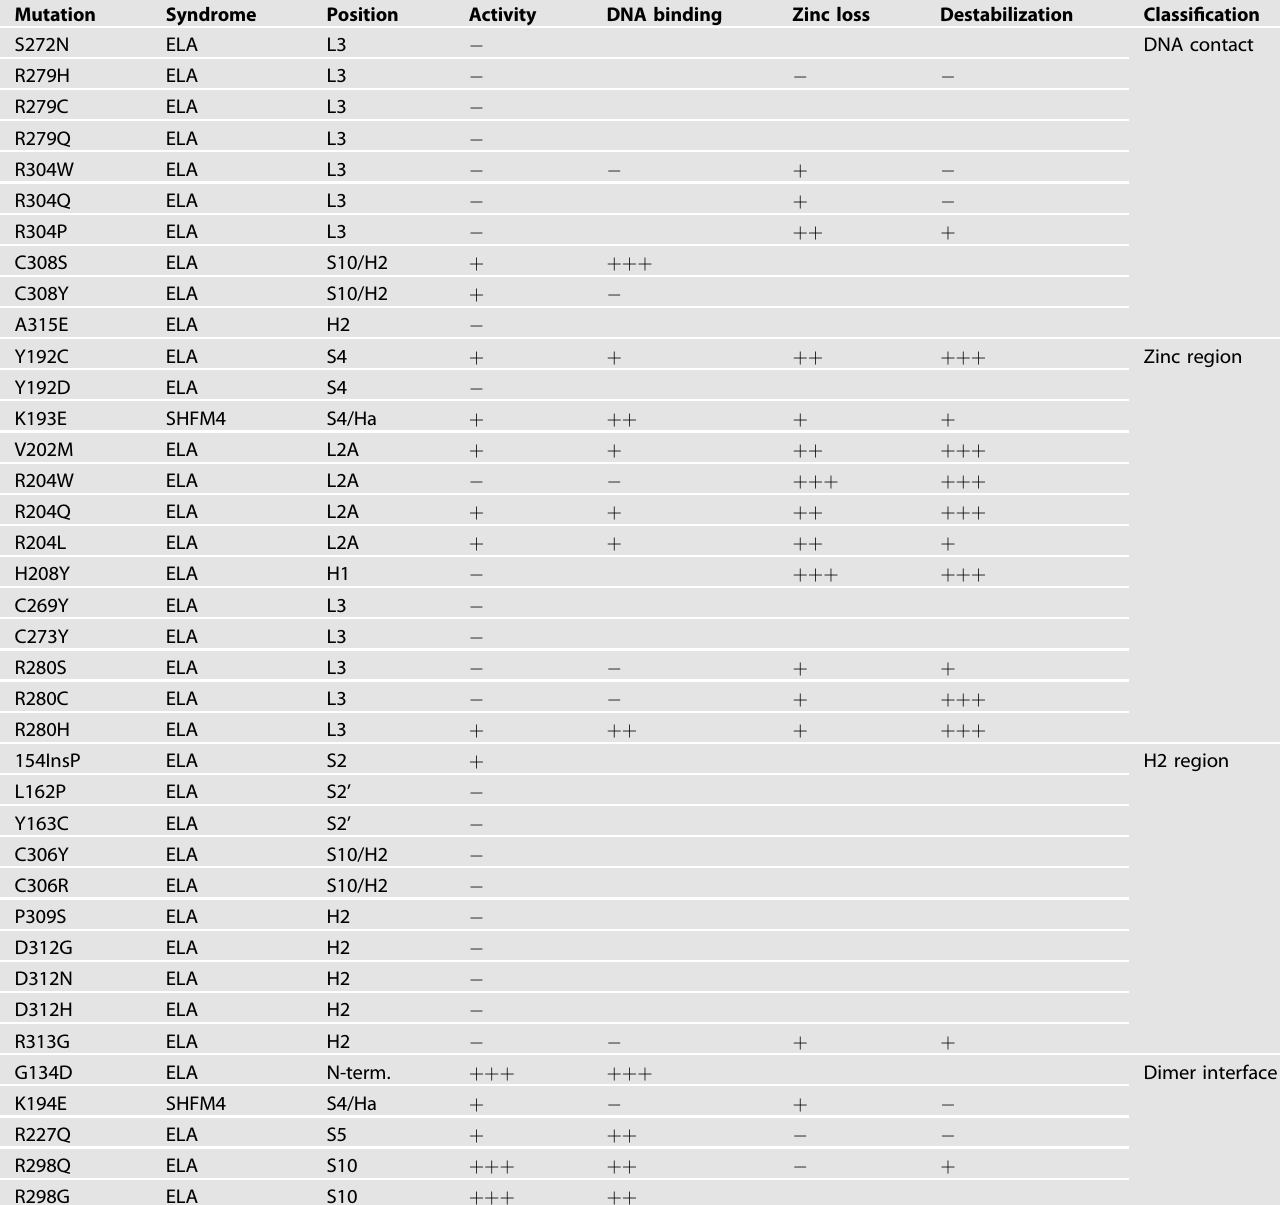
Table 1. Summary of experimental data and classi fi cation of p63 DBD